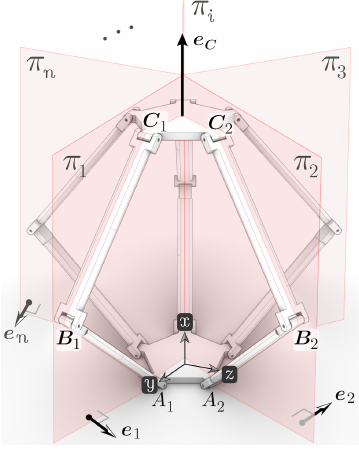
Figure 2. n –sided Sarrus